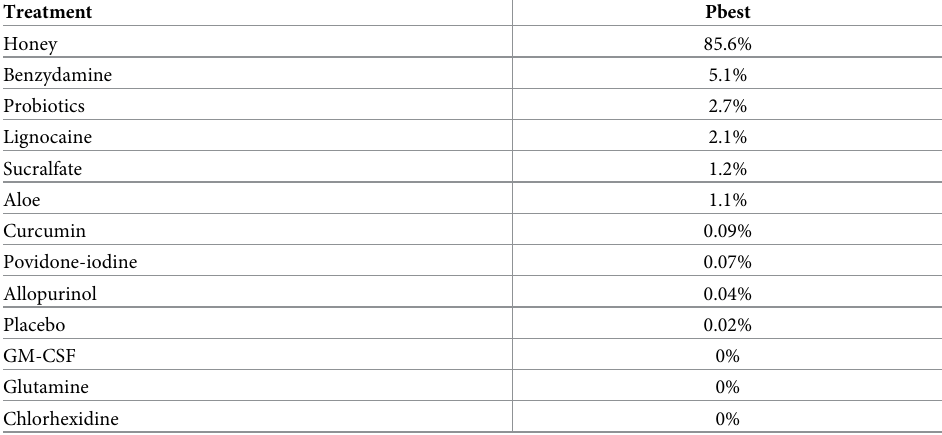
Table 2. Rank probability to be the best treatment (PrBest) by the moderate-severe oral mucositis of each treat- ment of patients with